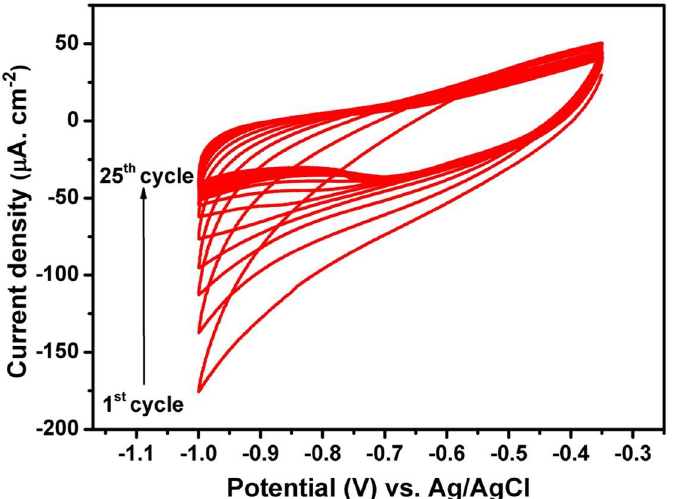
Figure 3. Cyclic voltammograms of TiO 2 NTs electrode in 0.5 M LiTFSI + 0.5M methyl ether methacrylate poly (ethylene glycol) (MMA-PEG)500. The curves were recorded in the potential window of −0.35 to −1 V vs. Ag/AgCl (3M KCl) at the scan rate of 10 mV s −1 . Molecules 2020 , 25 , x FOR PEER REVIEW